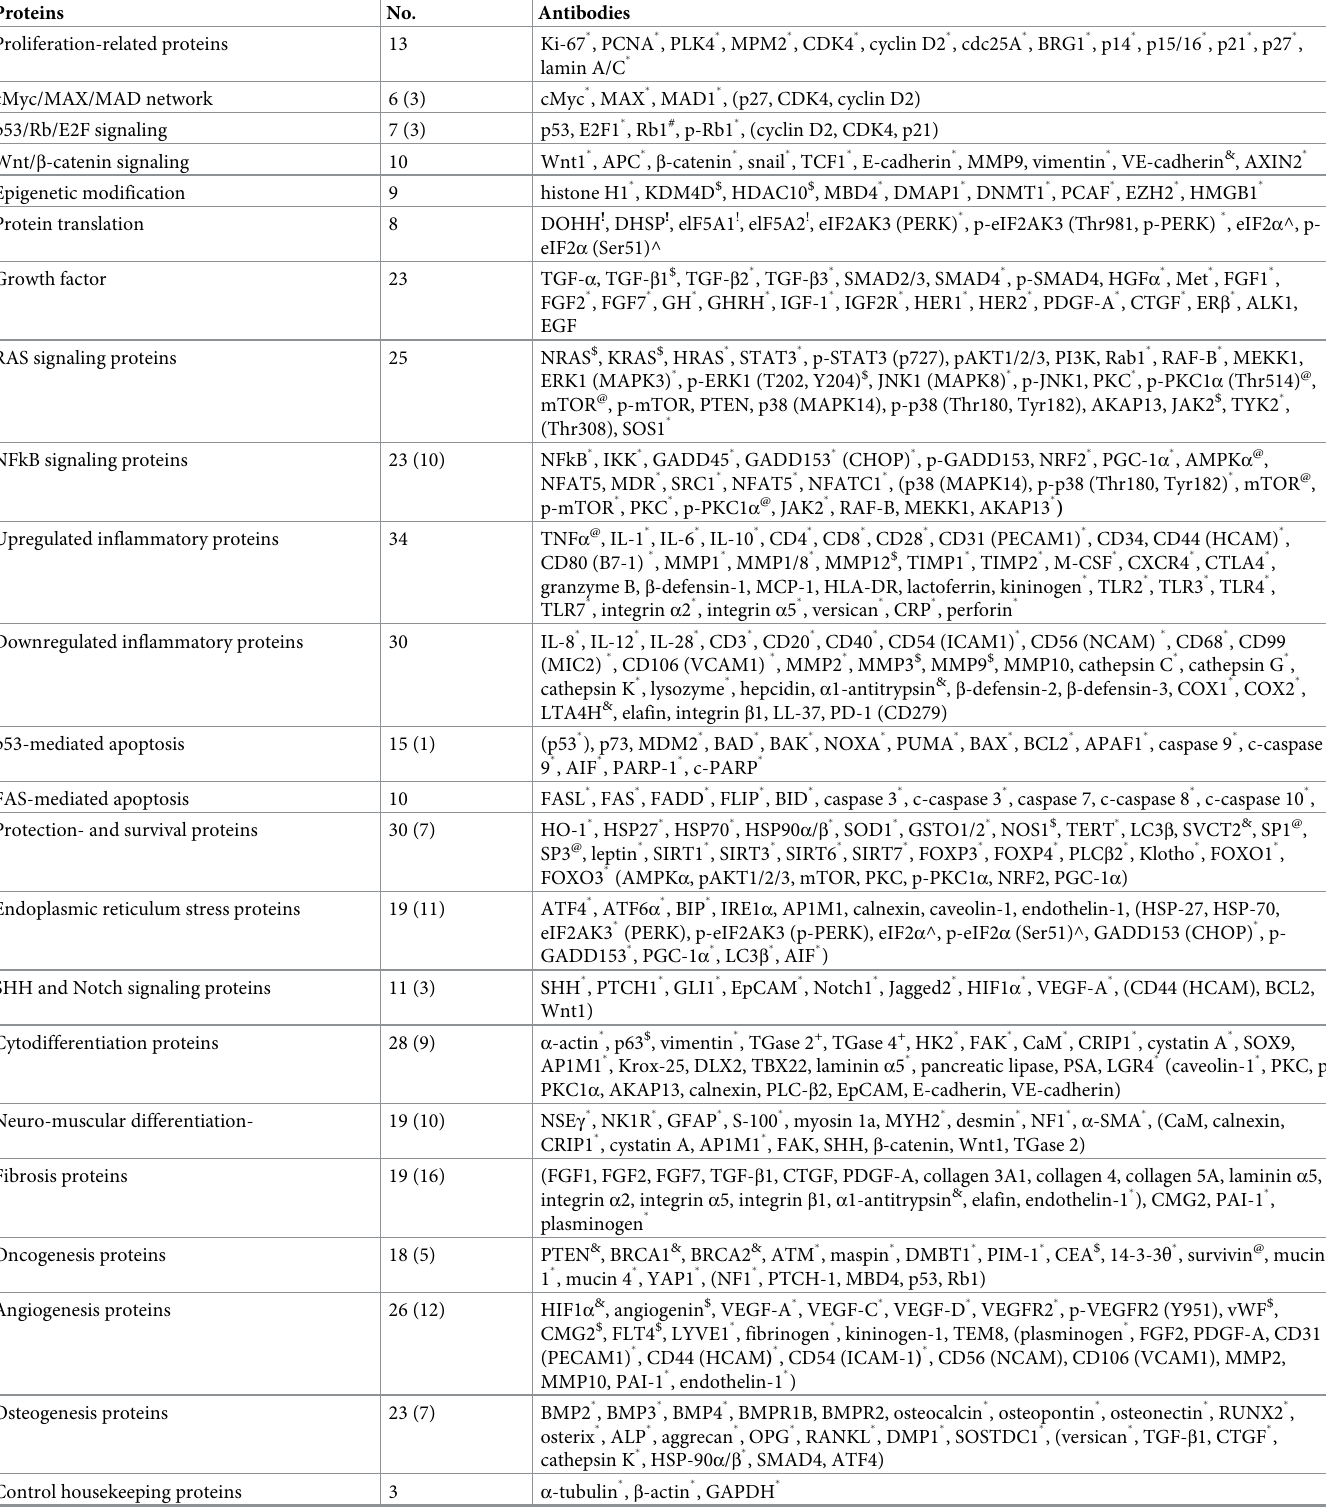
Table 1. Antibodies used in the